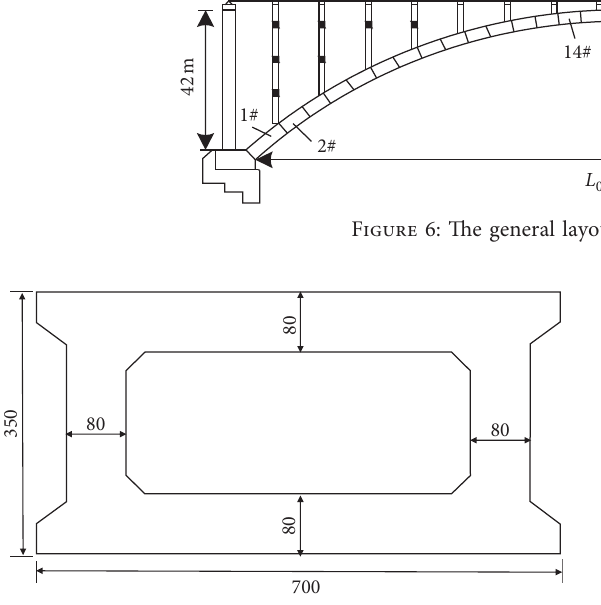
Figure 7: The arch foot section (units: cm).